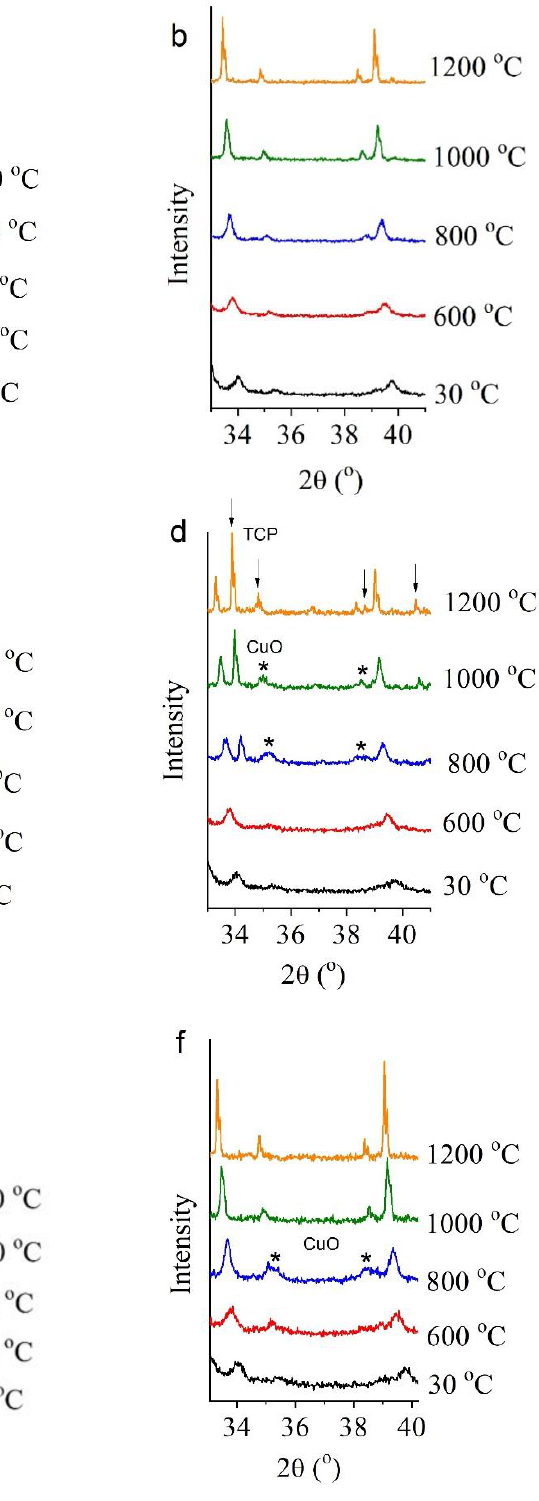
Figure 7. XRPD patterns recorded during in situ heating of samples 0.0Cu ( a , b ), 0.5Cu-Ca ( c , d ), and 0.5Cu-OH (e, f ) in ambient air.  — TCP reflections; * — CuO reflections. 0.5Cu-OH ( e , f ) in ambient air. ↓ —TCP reflections; *—CuO